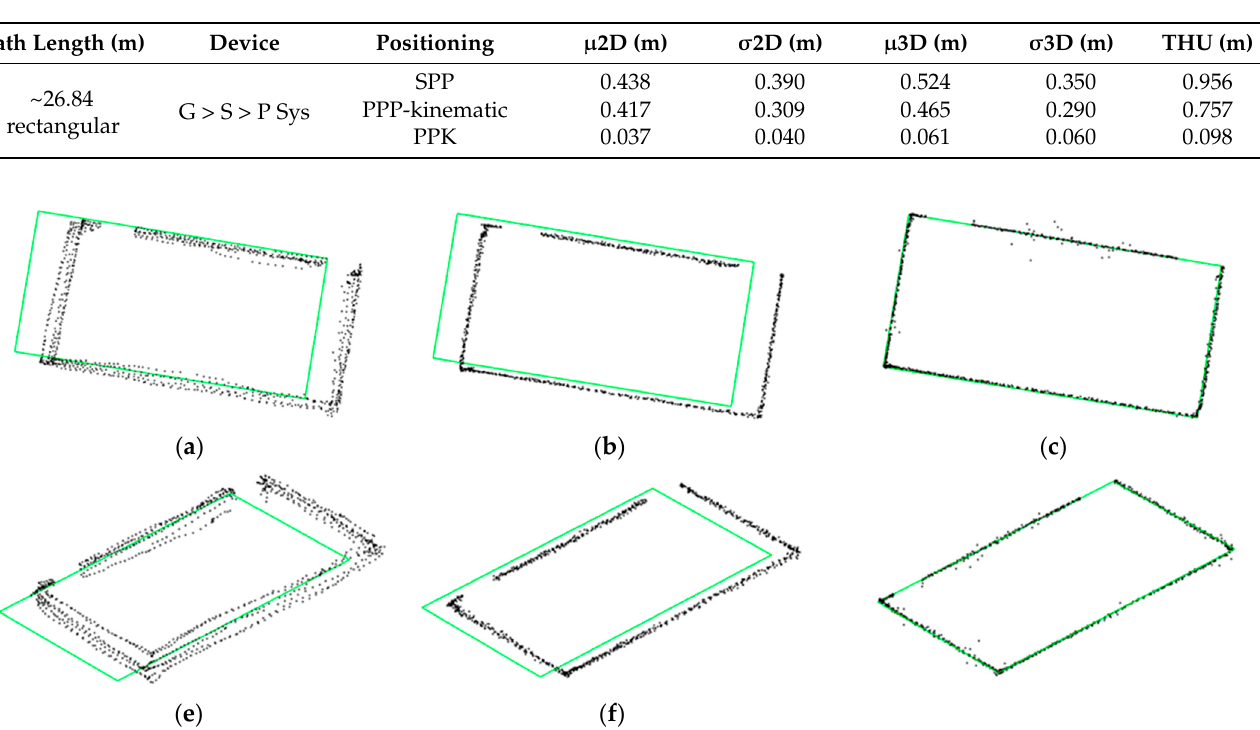
Table 12. Performance in the GNSS kinematic positioning of the G > S > P Sys in the pool test.